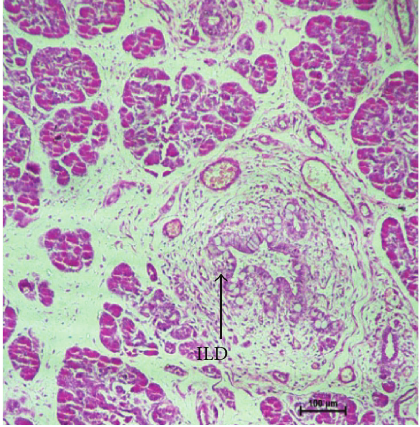
Figure 12: 54cm CVRL (195 days) showing blood vessels (BV) and interlobular duct (ILD) in interlobular stroma. Hematoxylin and eosin ×